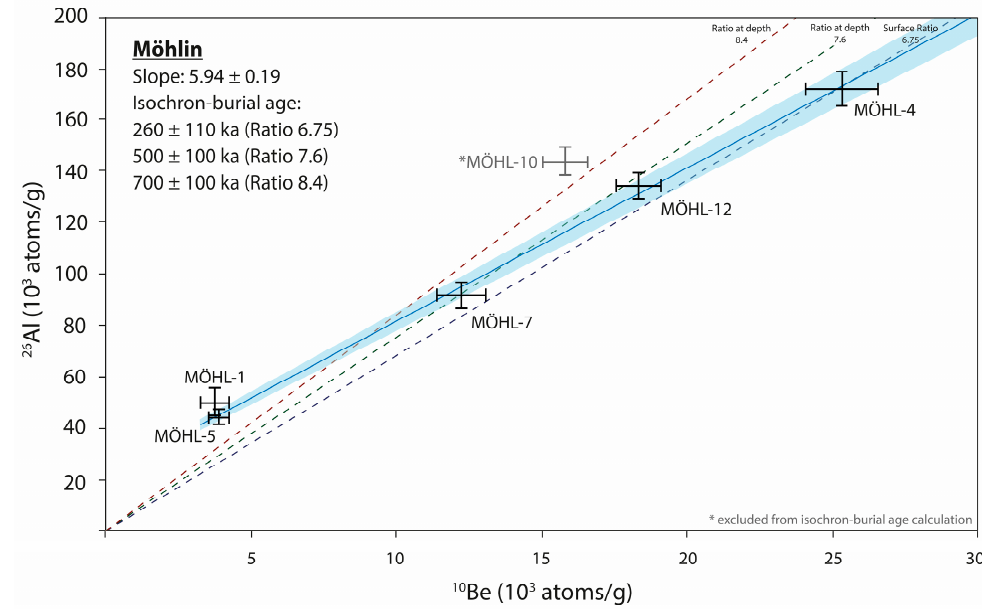
Figure 8. Isochron plot of the samples from the Möhlin site (the samples are plotted with 1 σ uncertainties and the isochron-burial ages calculated with the initial ratios 6.75, 7.6, and 8.4). The best fit isochron-line is indicated in blue and the light blue envelope shows the 1 σ solution space. The sample indicated in gray and labeled with an asterisk (*) is defined as an outlier and therefore excluded from the isochron-burial age calculation.